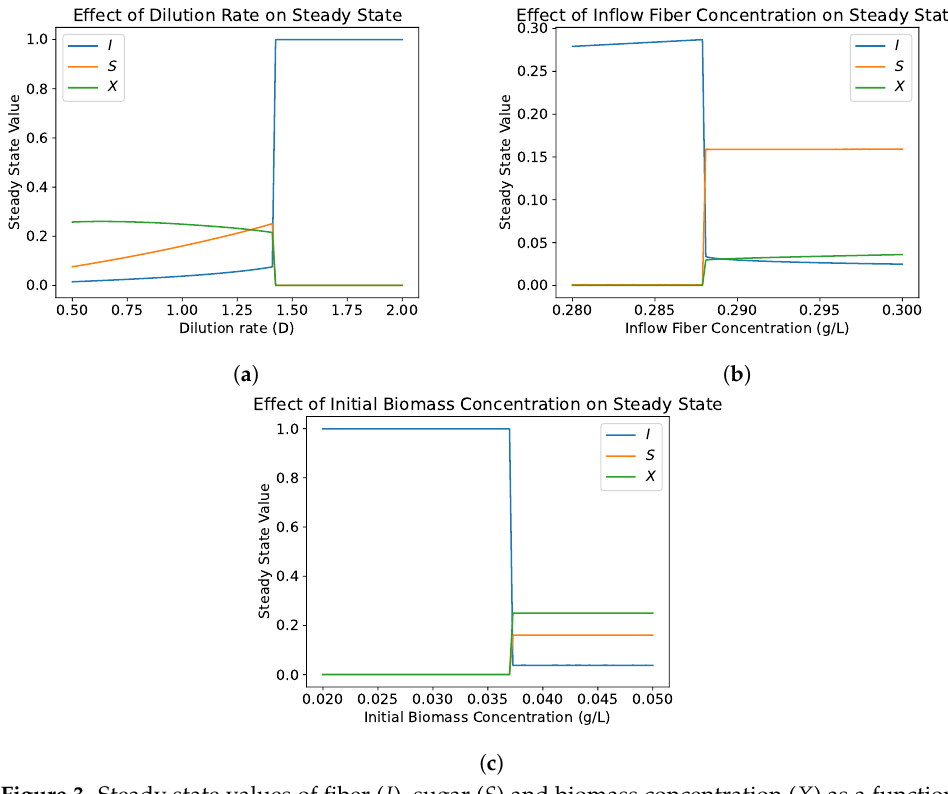
Figure 3. Steady state values of fiber ( I ), sugar ( S ) and biomass concentration ( X ) as a function of ( a ) dilution rate ( D ), ( b ) inflow fiber concentration ( I ∞ ), and ( c ) initial biomass concentration ( X 0